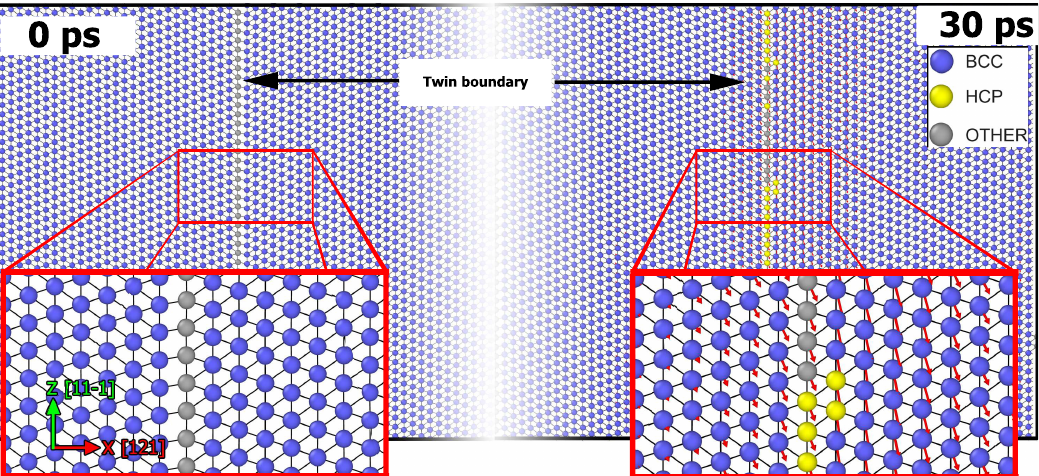
Figure 6. Snapshot of one layer of atoms on the ( ¯101 ) plane of a single-crystal containing four coherent twin boundaries at 0 ps and 30 ps (3.0% strain). Atoms are colored according to crystal structure types (blue, bcc; yellow, hcp; grey, disordered atoms) and red arrows are displacement vectors. Connections between atoms are shown by black